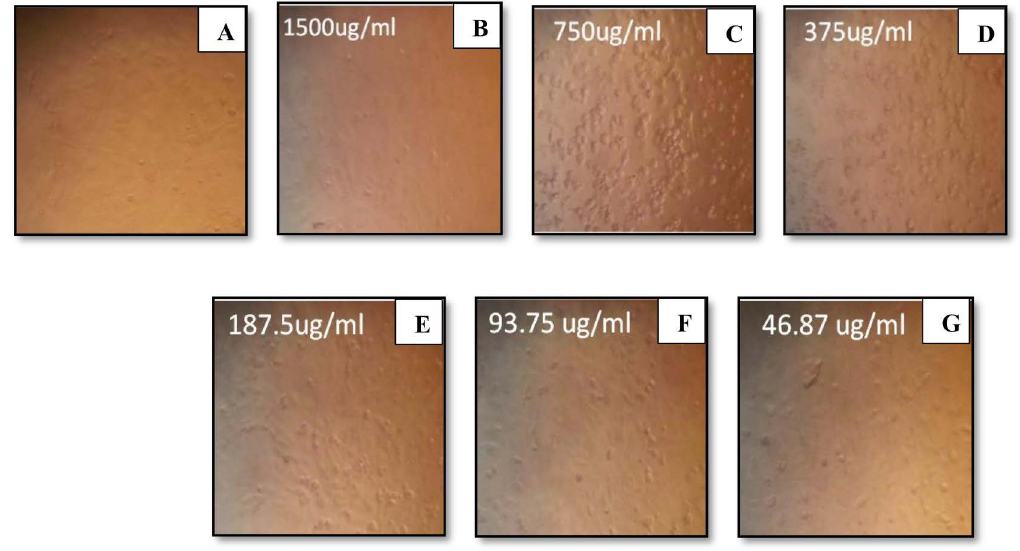
Fig. 7. Effect of different endotoxin concentrations on cell viability of Mcf-7 (A) Control (untreated) Mcf-7 cells. (B-G) Mcf-7-treated cells with